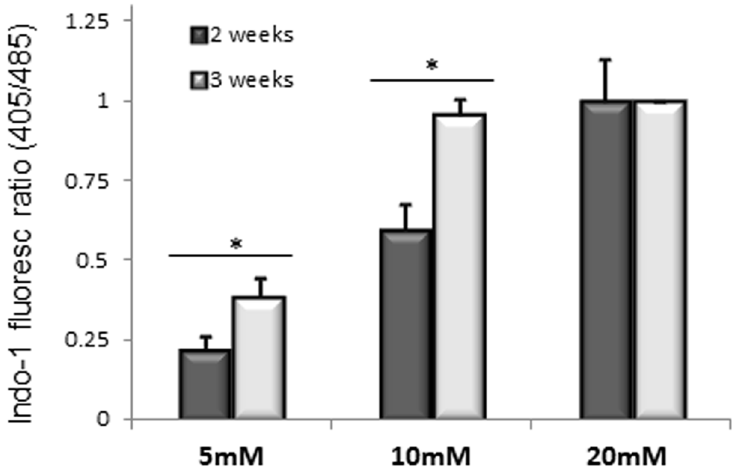
Figure 1. Caffeine dose response. Histogram of Indo-1 response to increasing concentrations of caffeine in adenovirally-transduced equine myotubes. Results show mean ( + / 2 1 SEM) derived from 40 myotubes from 2 control horses sequentially exposed to 5, 10 and 20 mM caffeine at 2 and 3 weeks’ differentiation.